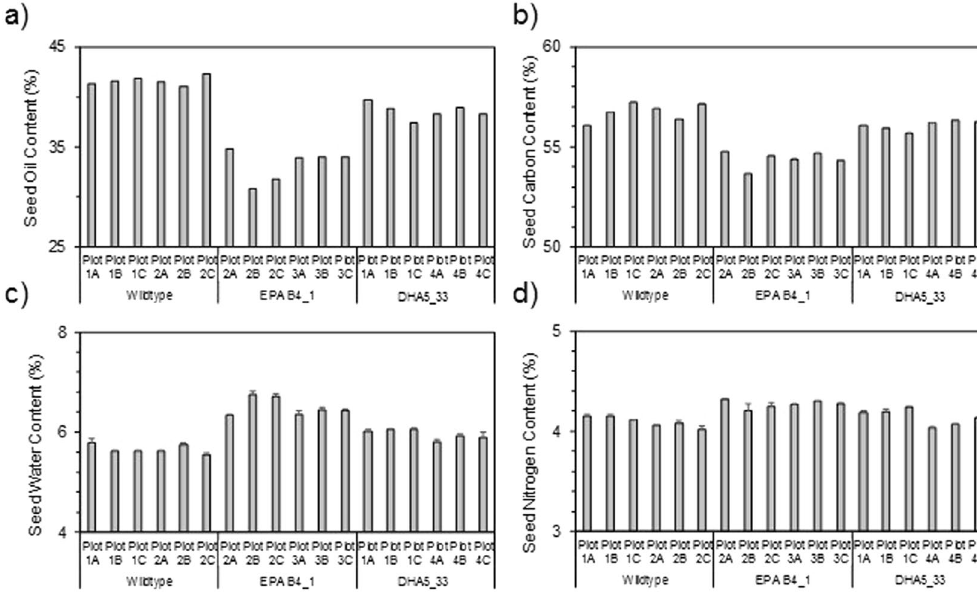
Figure 4. Seed yield and agronomic performance. ( a ) Total seed oil (n = 6 + / − SE); ( b ) carbon (n = 6 + / − SE); ( c ) water (n = 19 + / − SE) and ( d ) nitrogen (n = 6 + / − SE) content was determined and presented for each sub- plot of the field grown C. sativa